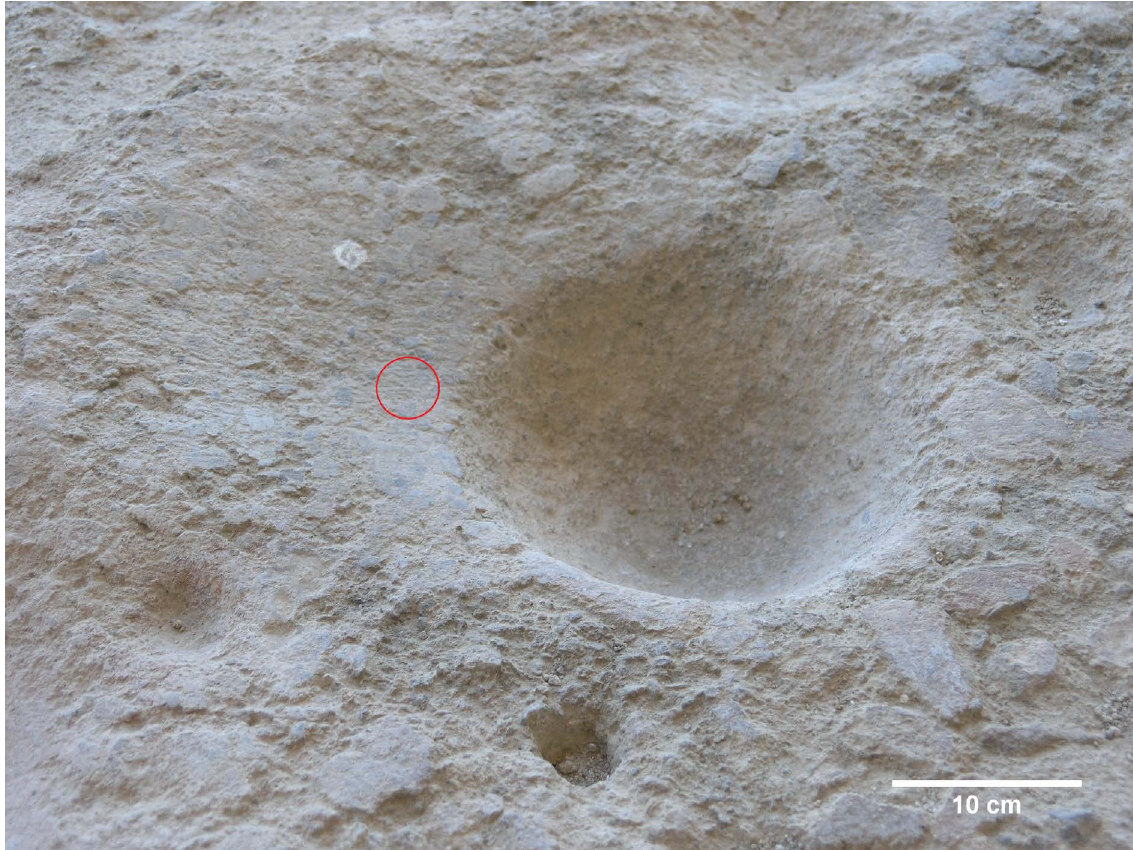
Figure 7. Grinding surface adjacent to mortar depression on RMP-33, the red circle indicates the location of sample 3-1. Scale is